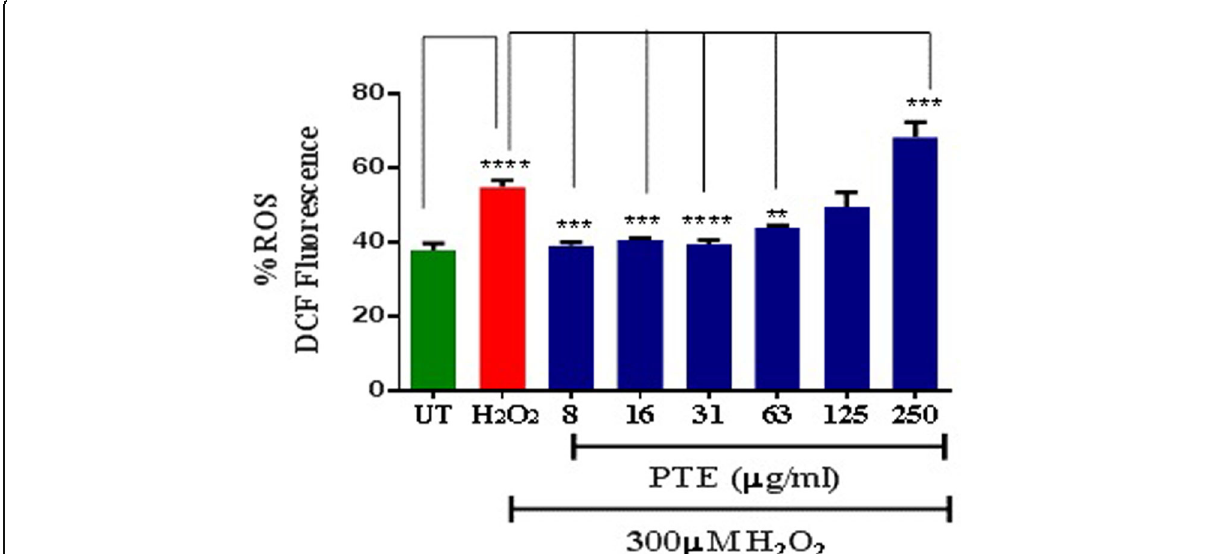
Fig. 7 Effect of PTE pretreatment (24 h) on ROS production by H 2 O 2 in dIMR32 cells. The data are expressed as mean ± SEM, n = 3. The label UT = untreated control cells. Statistical significance was analyzed with one-way ANOVA followed by Dunnett ’ s multiple comparison post-hoc test. Differences with p value less than p < 0.0001, p < 0.001 and p < 0.05 against 300 μ M H 2 O 2 treatment were considered statistically significant. **** p < 0.0001, *** p < 0.001 and ** p <